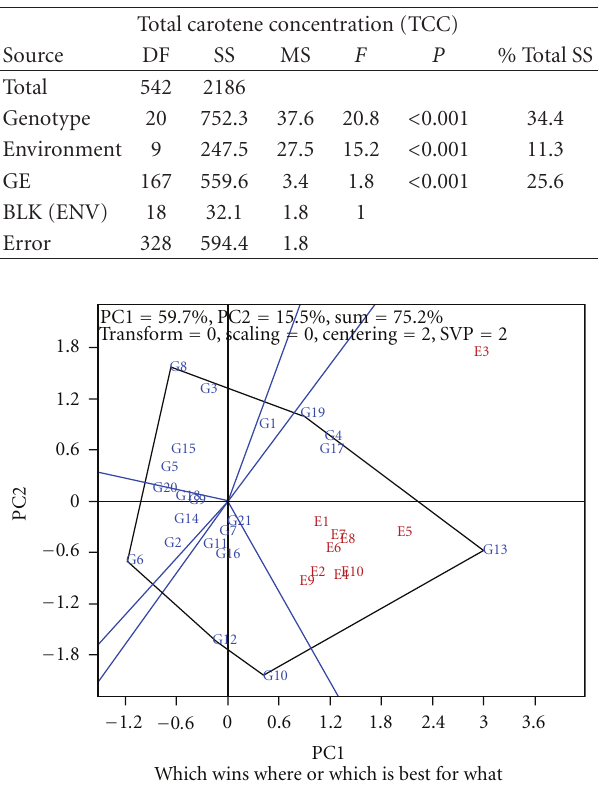
Figure 5: Mega-environment defined by di ff erent winning yellow- fleshed cassava genotypes tested in 10 environments for average TCC ( μ gg − 1